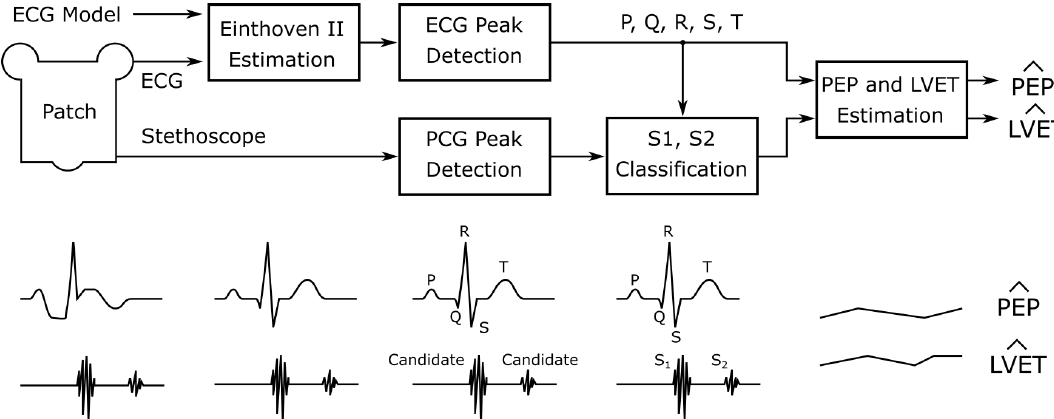
Figure 6. ECG and PCG peak detection and classification of S1 and S2 candidates before PEP and LVET